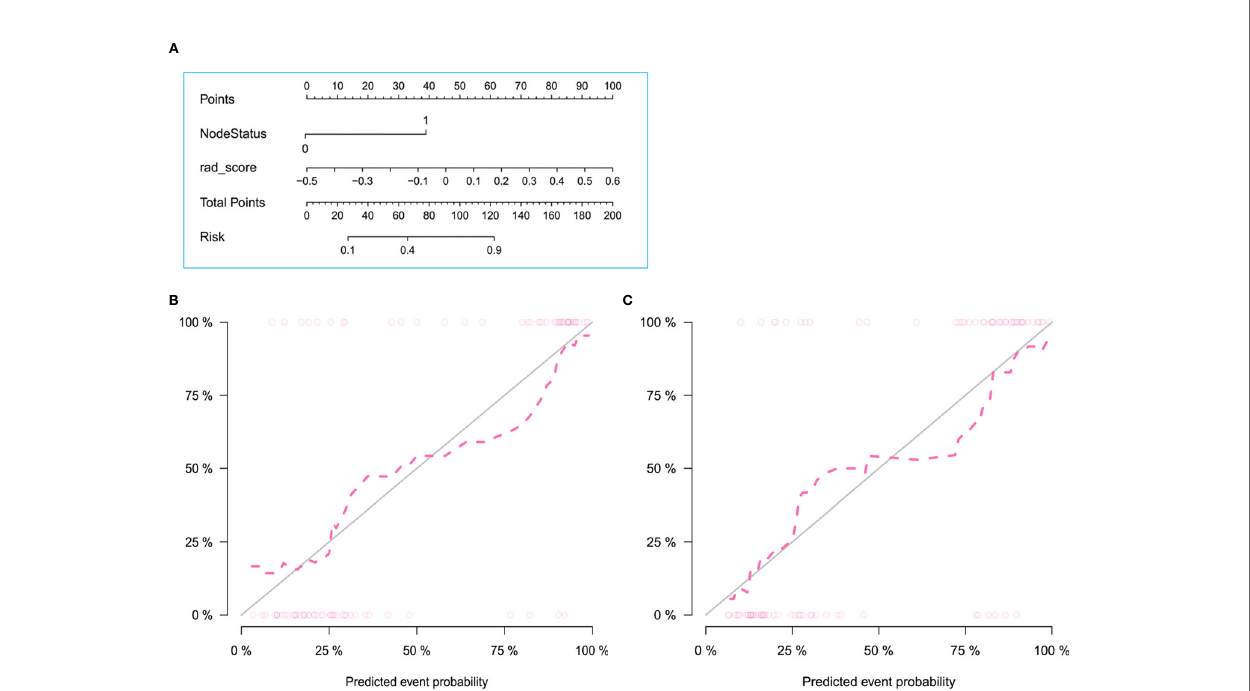
FIGURE 3 | Radiomics nomogram with radiomics signature and LN status (A) and calibration curves of the radiomics nomogram in the training (B) and validation (C) sets. Calibration curves indicate that the predicted probability has a good agreement with the actual state of axillary lymph node.